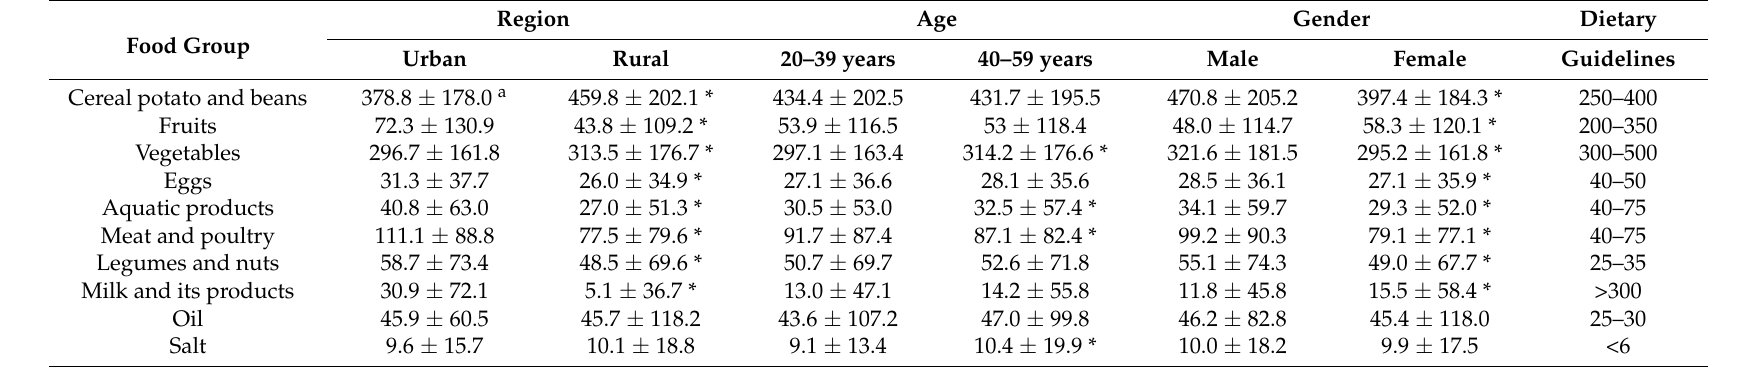
Table 2. Daily food intakes (g/day) of people by region, age and gender in